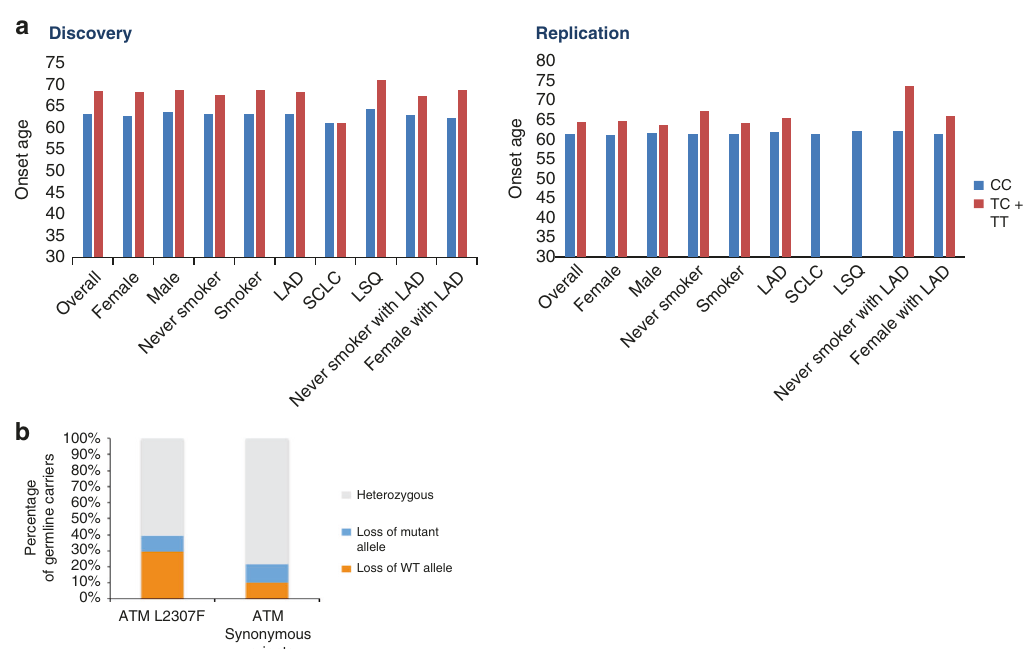
Fig. 4 The onset of lung cancer risk and biallelic two-hit events of ATM rs56009889. a rs56009889 affects the age of onset. The error bars are mean + the standard error of the mean (SEM). In the discovery data, the mean age of onset for lung cancer cases carrying L2307F was signi fi cantly higher than cases of non-carriers. Later age of onset was observed for overall lung cancer ( n = 15830), females ( n = 5810), males ( n = 10019), smokers ( n = 14006), LAD ( n = 6329) and females ( n = 2954) with LAD. In the replication data, a borderline signi fi cant difference in the age of onset was observed only in females with LAD ( n = 906) and non-smoker with LAD ( n = 293) though the sample size is small. P values were determined by the two sides t test without adjustment. No carrier of the T allele developed LSQ and SCLC in the replication data. b the rate of loss of heterozygosity targeting either ATM L2306F allele or synonymous variants in ATM gene. Source data are provided as a Source Data fi